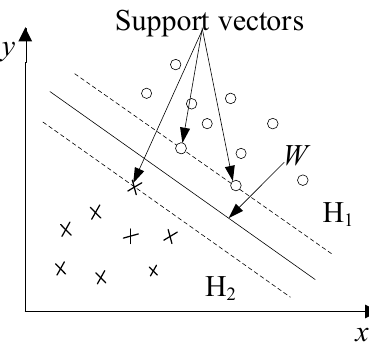
Figure 1. Optimization classification of a hyperplane under a linear condition.